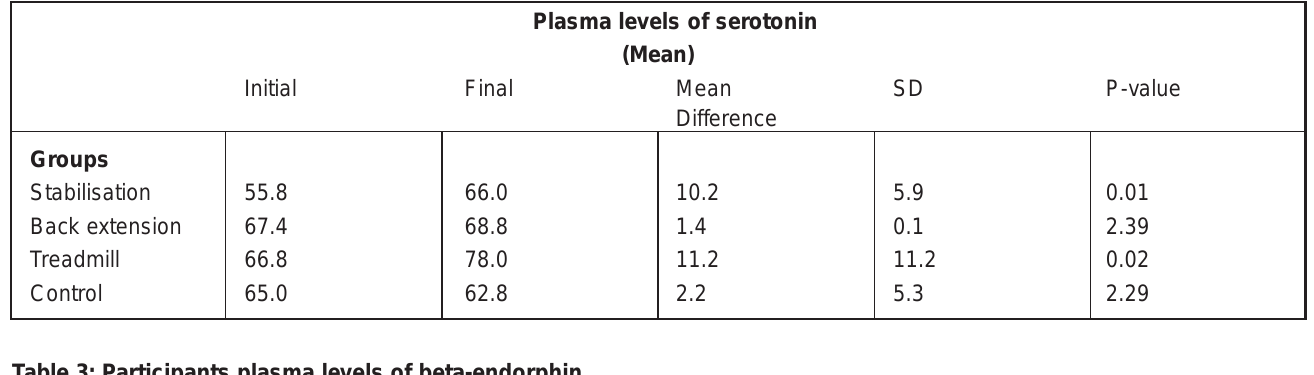
Table 2: Participants plasma levels of serotonin